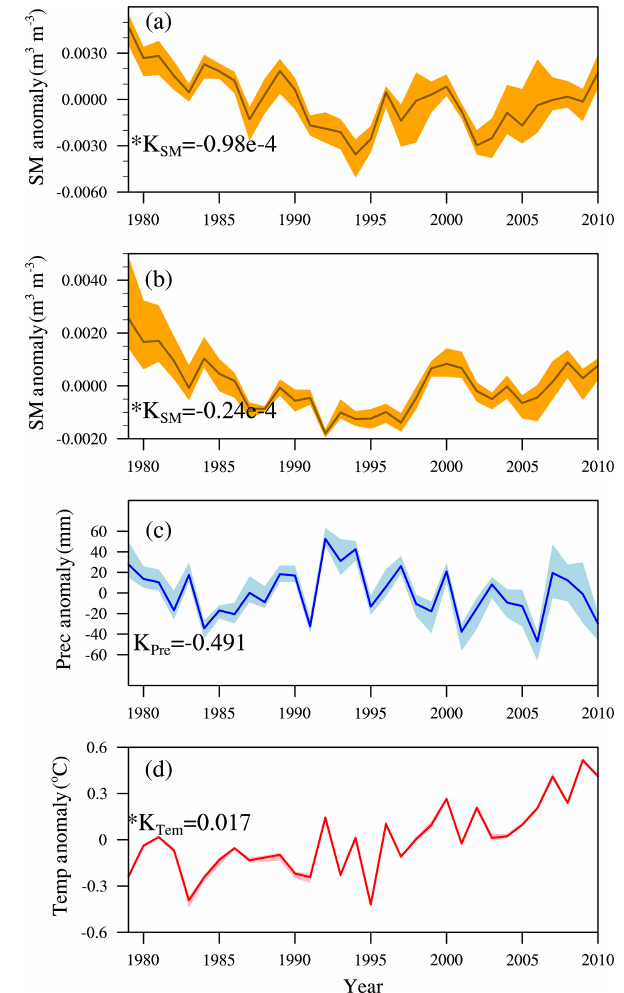
Figure 5. Annual mean (a) surface soil moisture, (b) deep soil moisture, (c) precipitation, and (d) temperature averaged globally from 1979 to 2010. ∗ = p < 0 . 05.